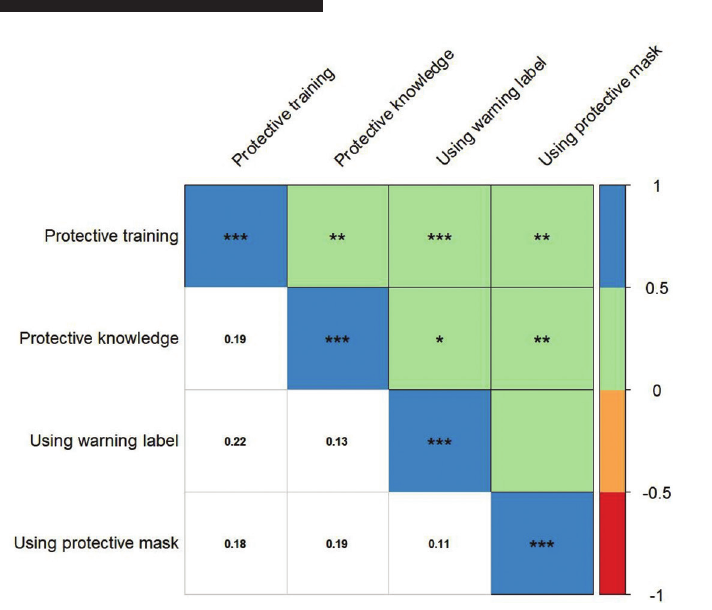
Figure 1. Association matrix of protective training for AD exposure, protective knowledge, using warning labels and using protective masks.